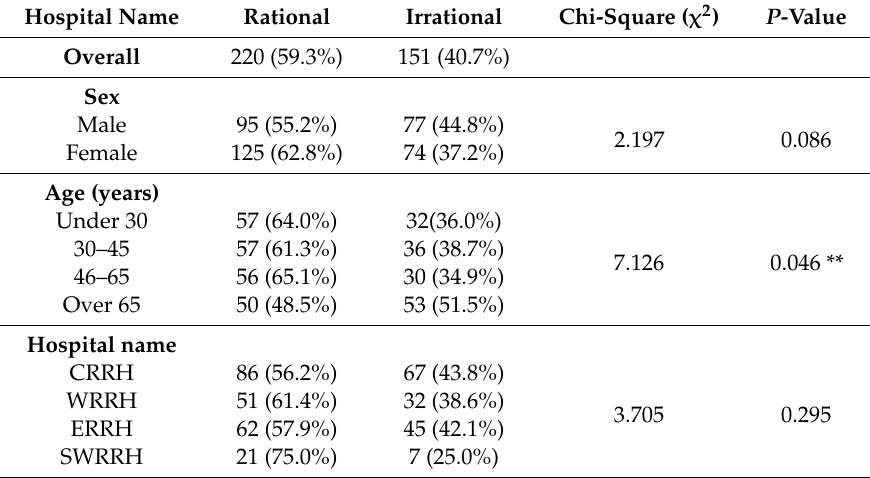
Table A1. Distribution of the appropriateness of the levofloxacin prescription in the study sample according to the